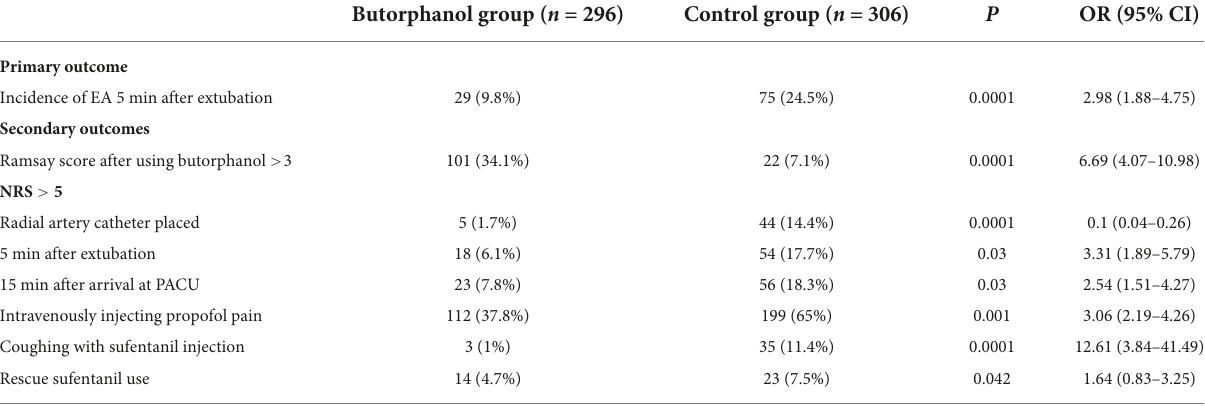
TABLE 3 Effectiveness